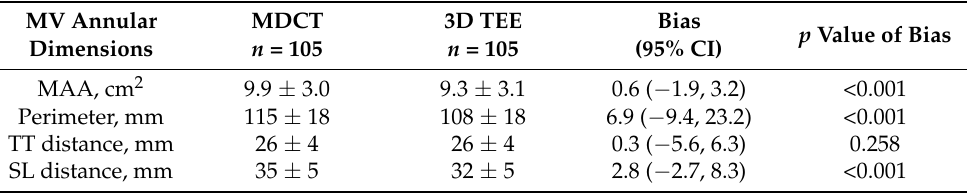
Table 2. Mitral annular dimensions measured by MDCT and 3D